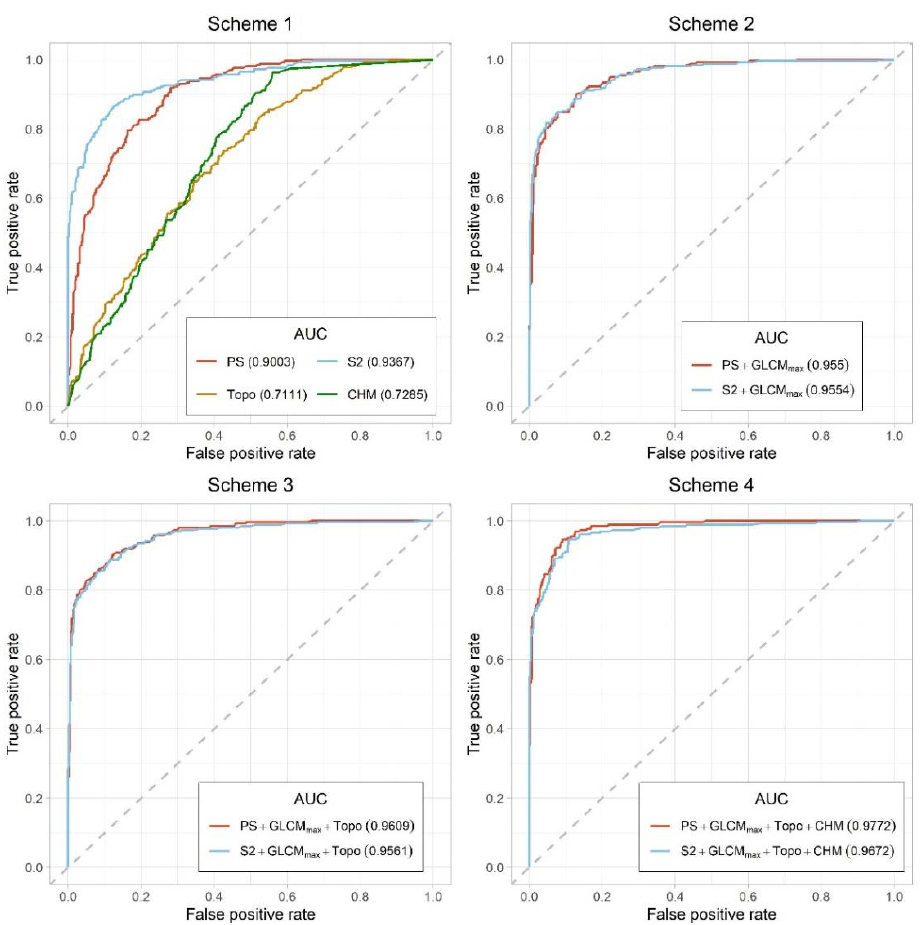
Figure 7. ROC curves and AUC for different feature spaces of each classification scheme.